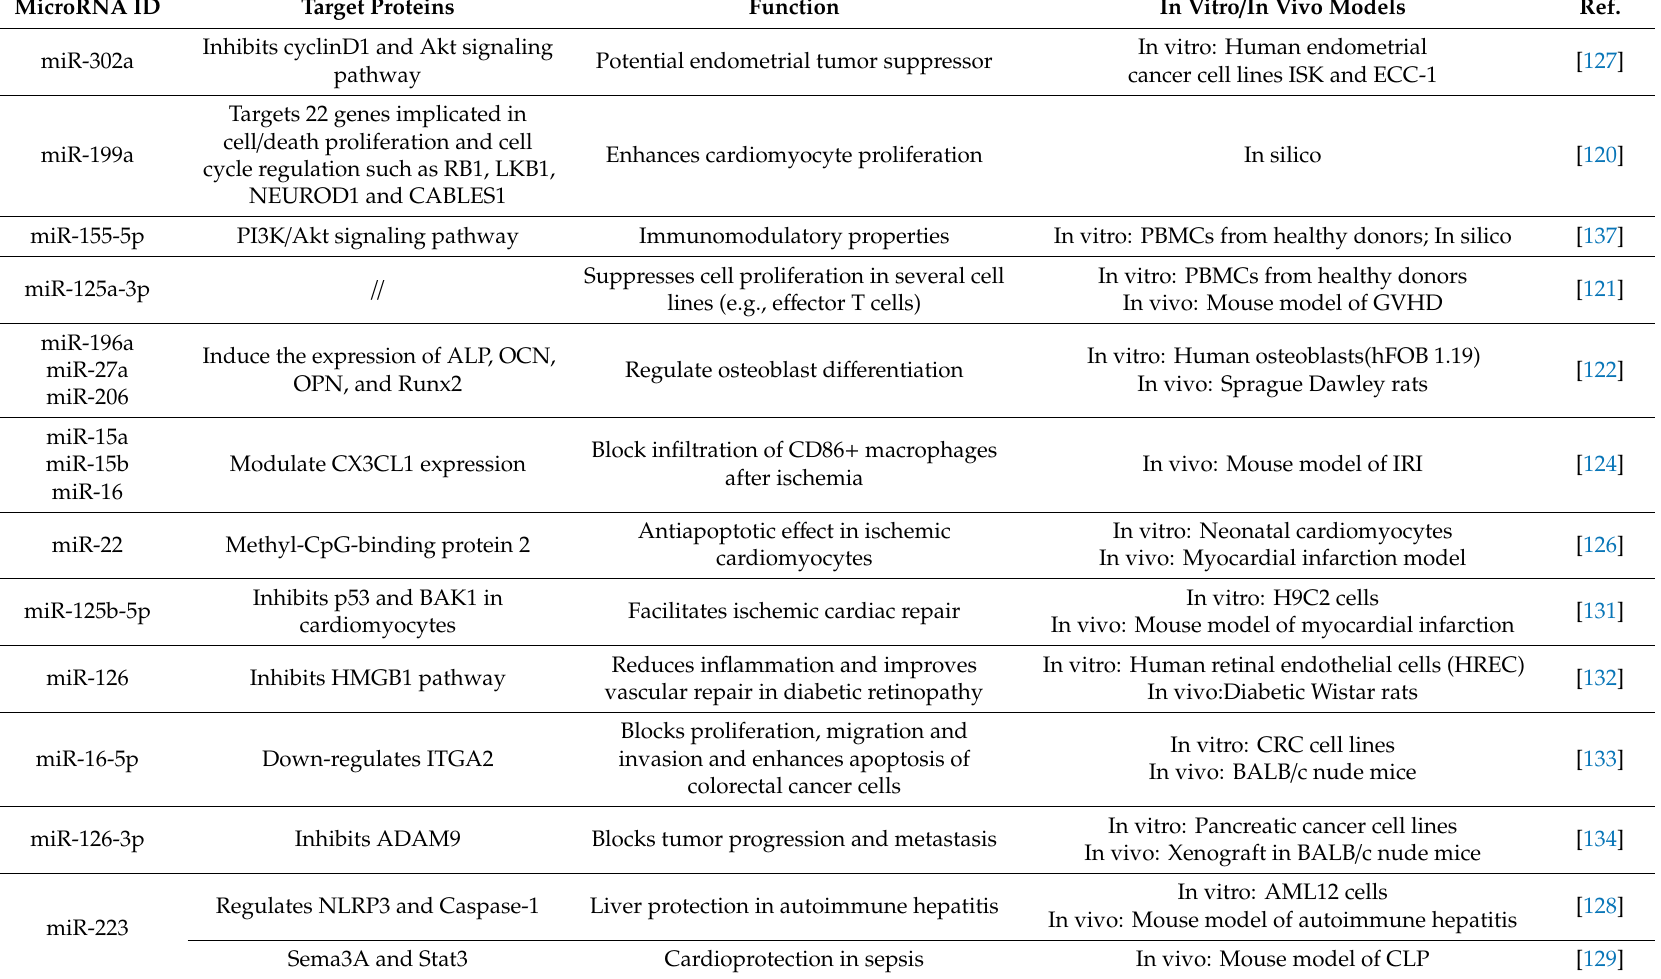
Table 3. MiRNAsfound in MSC-derived extracellular vesicles (MSC-EVs), their targets and